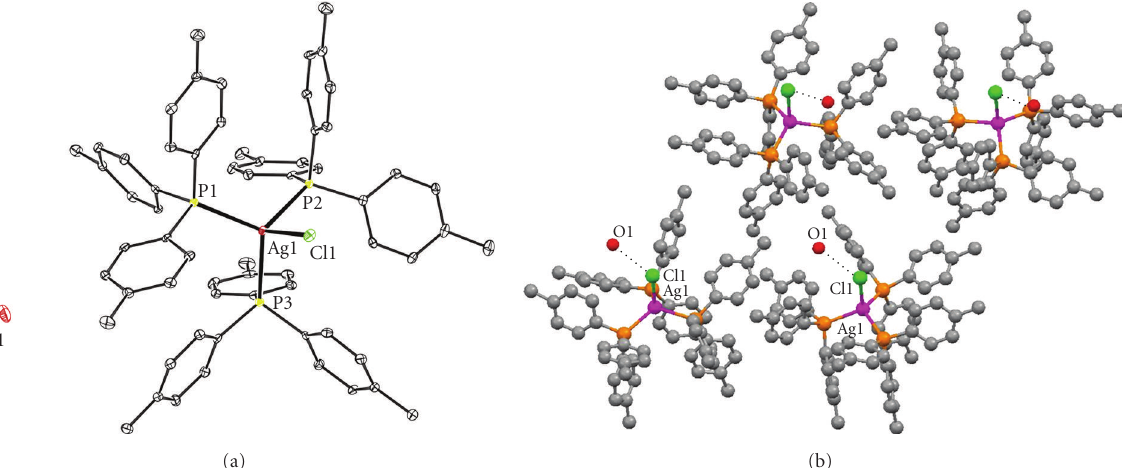
Figure 2: (a) ORTEP diagram of the crystal structure of complex 2 . (b) Packing diagram and hydrogen bonding interactions (Cl1 ··· O1) in 2